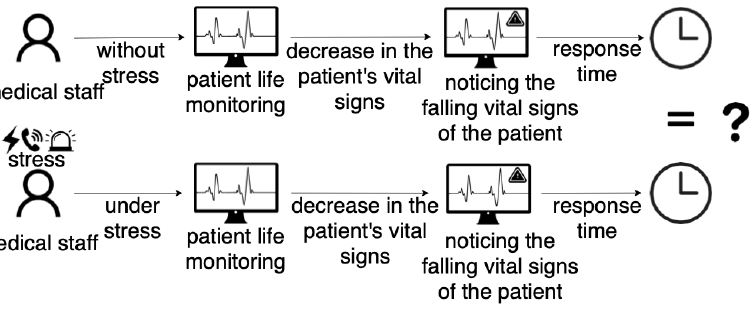
Figure 1. Problem definition. The question is about differences in the medical staff response time to the patient’s falling vital signs in a neutral (stress-free) and stressful